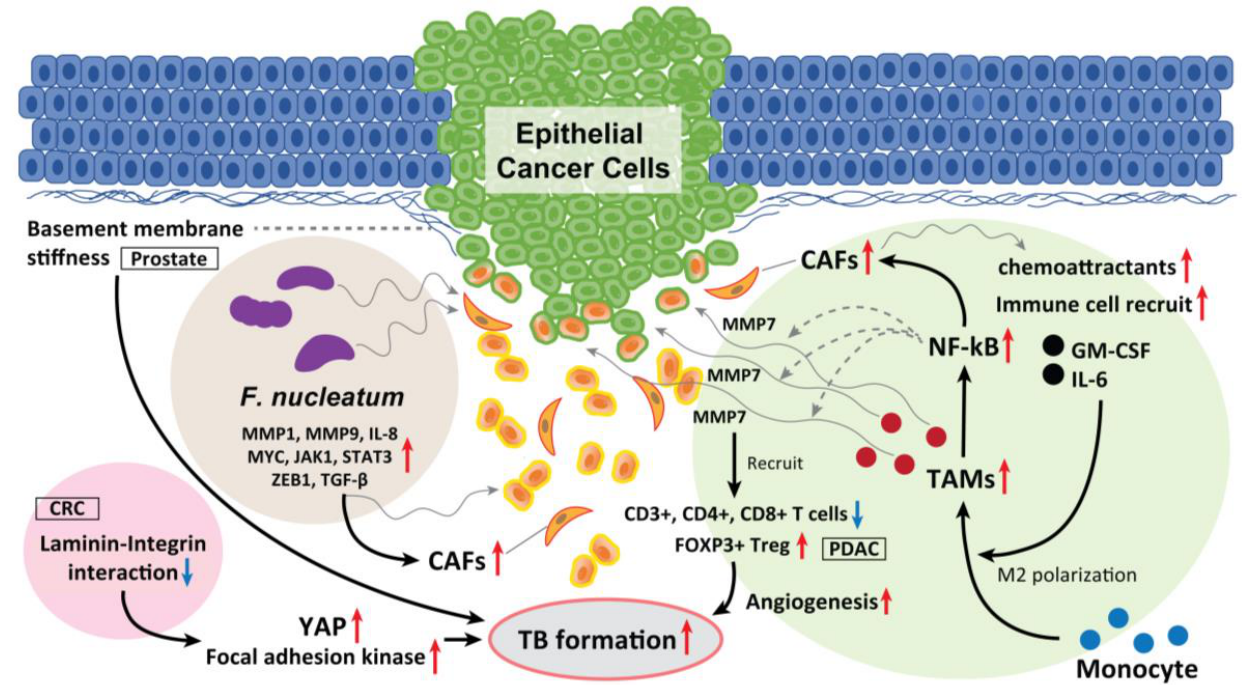
Figure 4. The role of TAM, laminin–integrin interaction, basement membrane stiffness, and F. nucleatum as a TB driver. TAMs located in the surrounding of the tumor mass induce loss of tight junction proteins at tumor cell–cell contacts, and cause TB from the colonosphere bulk of CRC. This is due to the MMP7 secretion by activating the NF- κ B pathway. Moreover, CAF-derived exosomes serve as chemoattractants, which recruit various immune cells, including monocytes, promoting CRC progression and the release of cancer cell-derived exosomes. In PDAC, high-grade TB cases display lower M1 macrophages in the stroma and increased M2 macrophages in the tumor tissue, and displayed fewer CD3+, CD4+, and CD8+ T cells. Inversely, FOXP3+ T regs were found to be ele- vated in high-grade TB cases. CAFs also recruit granulocyte-macrophage colony-stimulating factor